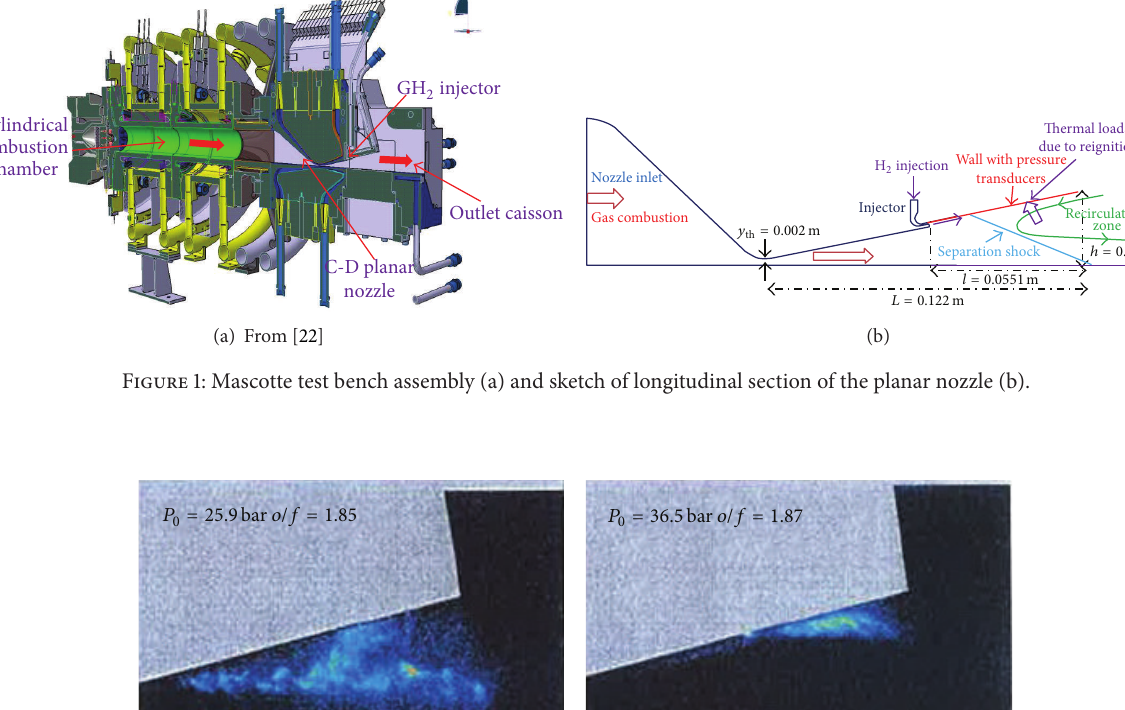
Figure 2: PLIF images of OH radicals from